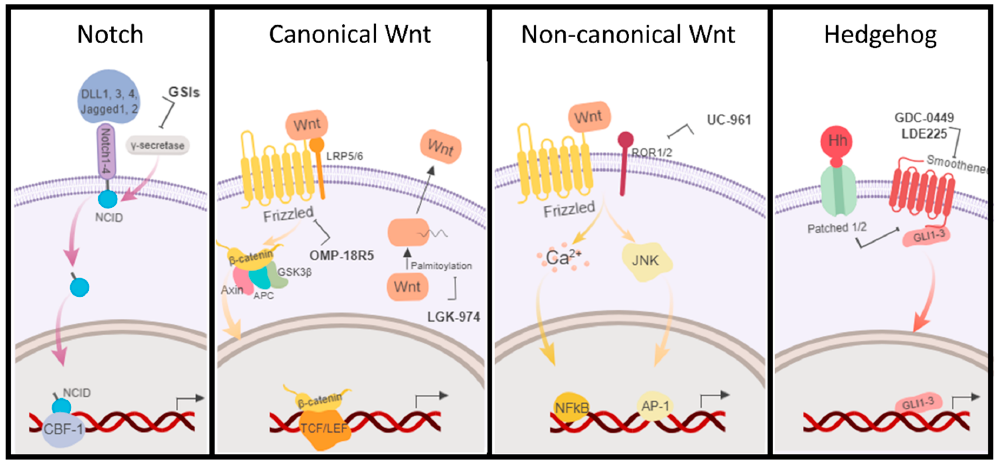
Figure 3. Schematic representation of the main BCSC signaling pathways, Notch, Wnt (canonical and non-canonical), and Hedgehog (Hh). Some of the current drugs in clinical trials directed to BCSC pathways are indicated. GSIs: γ -secretase inhibitors (MK-0752, RO4929097, and PF-03084014). Notch counts with four transmembrane receptors (Notch1-4) that interact with five ligands (DLL1, 3, 4, Jagged1, 2). Due to this heterogeneity and the wide spectrum of possibilities, the most clinically evolved approach is the inhibition of Notch signaling using γ -secretase inhibitors (GSIs). Notch receptors are cleaved by γ -secretase, releasing the Notch intracellular domains (NCID) and subsequently activating Notch signaling. NCID is then translocated to the nucleus where it induces gene transcription by interacting with other co-factors. The experimental γ -secretase inhibitor MK- 0752 (Table 1) from Merck in combination with docetaxel has reached phase I/II clinical trials for metastatic breast cancer. Undergoing serial patients’ biopsies showed a decrease in cell population with CD44 + /CD24 − phenotype, ALDH + activity and a reduction in MSFE, leading to the first evidence of the benefits of BCSC-targeted therapy thought the inhibition of Notch pathway in combination with systemic cytotoxic therapy [107]. Other GSIs for the treatment of breast cancer that have reached clinical trials are RO4929097 in combination with paclitaxel and carboplatin in patients with stage II/III TNBC (ClinicalTrials.gov Identifier: NCT01238133), PF-03084014, and LY450139 (semagacestat), the first GSI to enter phase III clinical trials for the treatment of Alzheimer’s Disease. CB-103 is a protein-protein interaction inhibitor targeting Notch signaling that is currently in phase I/II clinical trials for advanced or metastatic breast cancer (Table 1).